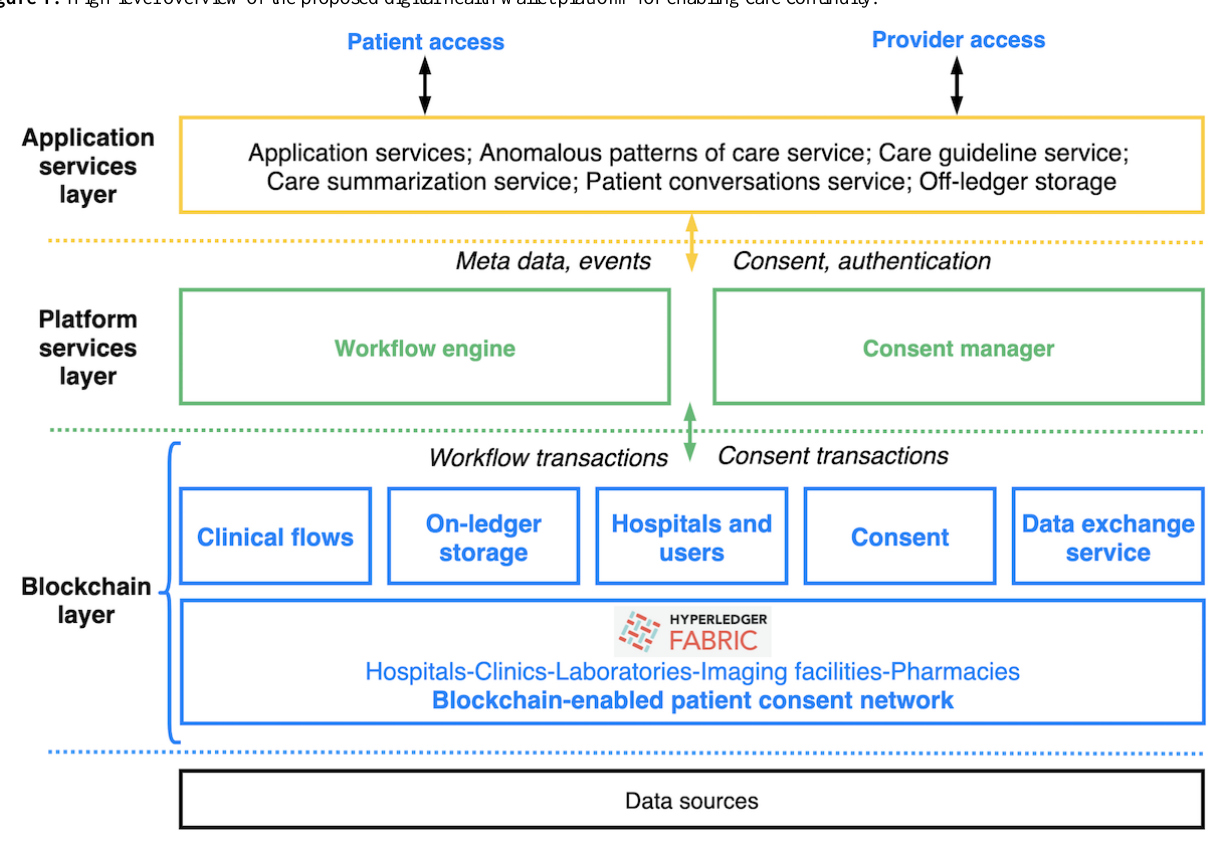
Figure 1. High-level overview of the proposed digital health wallet platform for enabling care